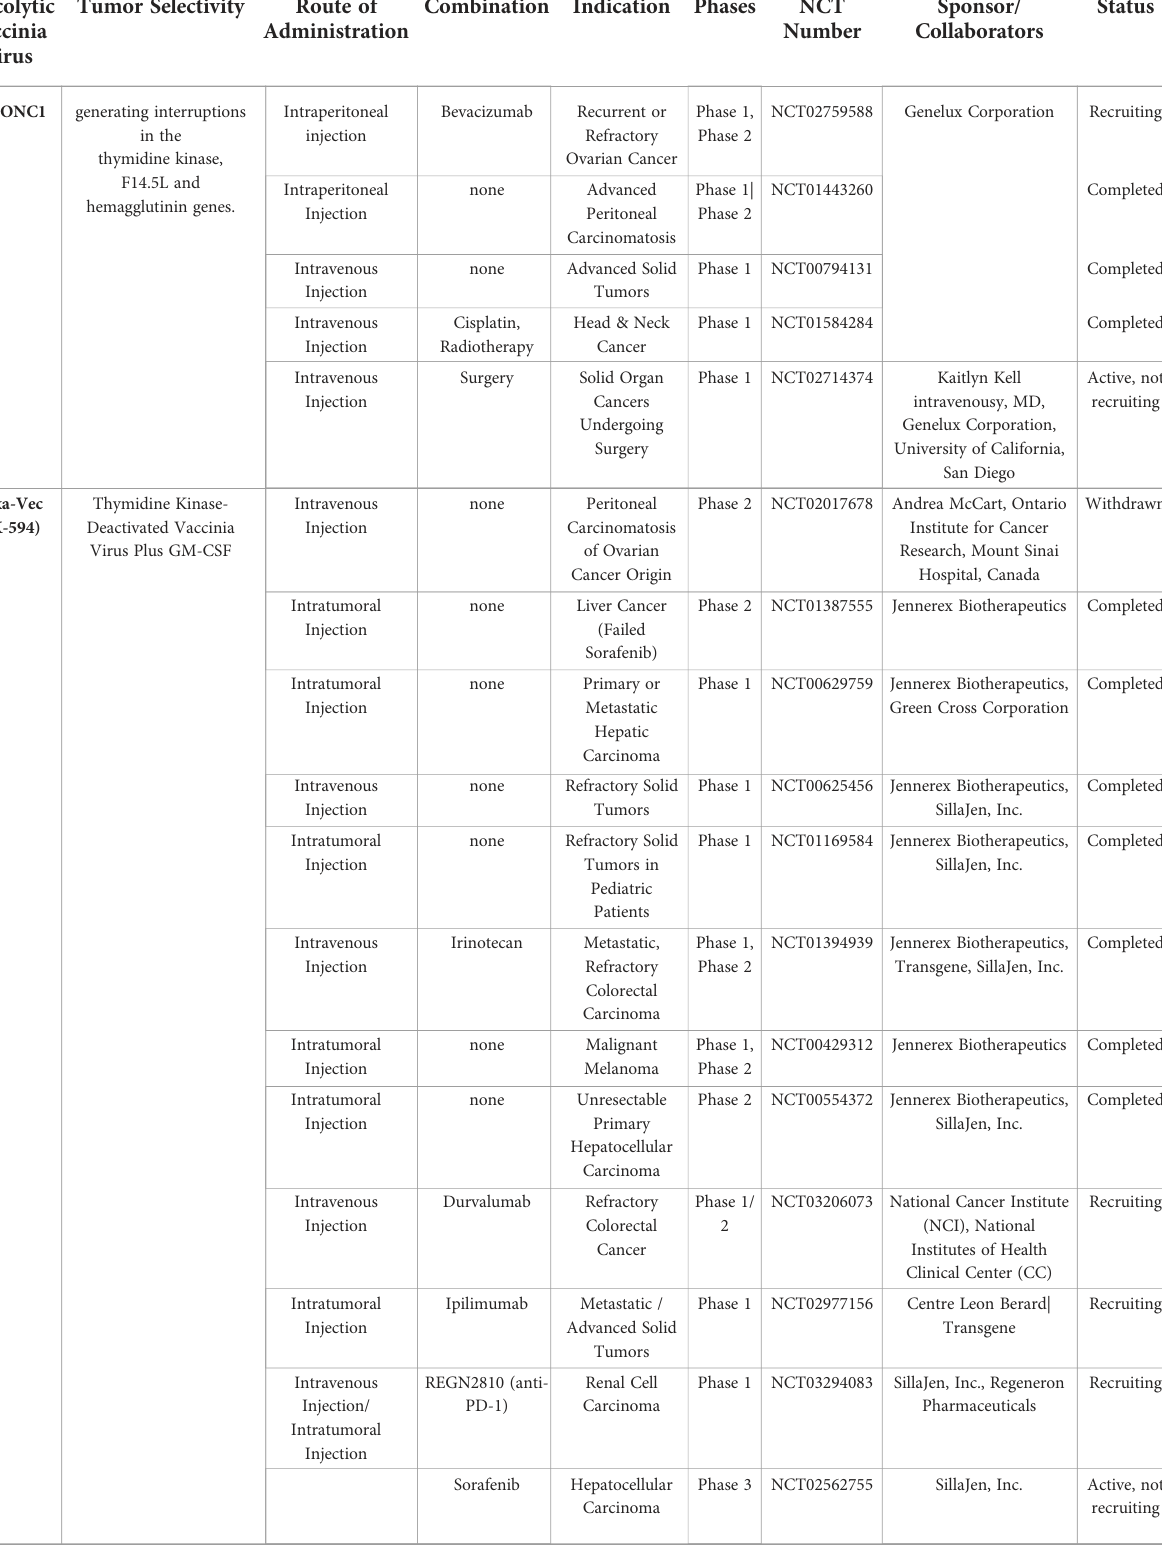
TABLE 3 Oncolytic vaccinia viruses tested in current clinical trials. Oncolytic vaccinia